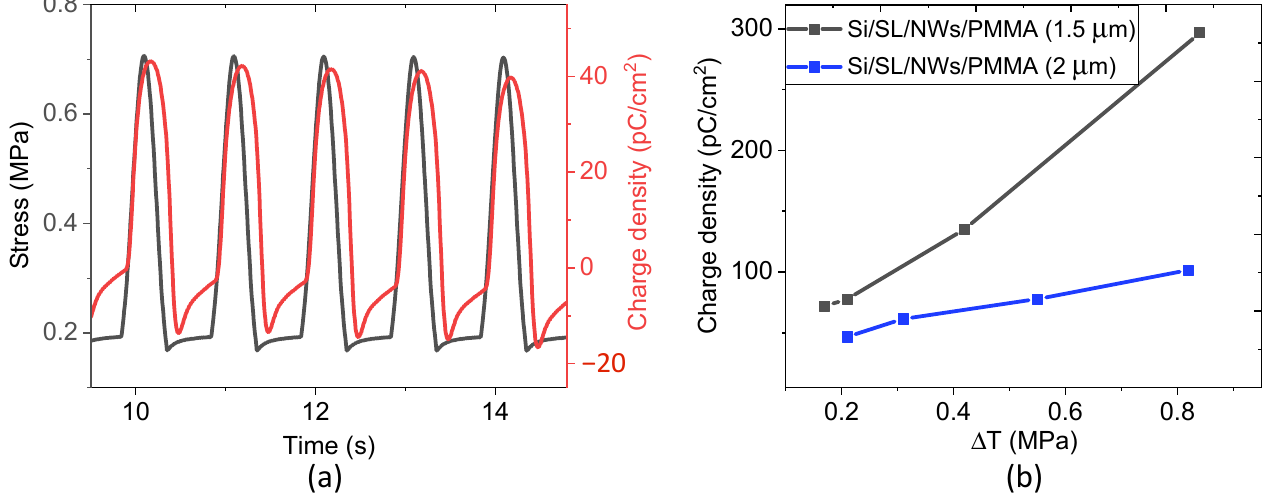
Figure 16. Piezoelectric characterization, performed under a dynamic stress of 1 Hz. ( a ) Time evolution of stress and charge density of the Si/SL/NWs/PMMA (2 µm) composite. ( b ) Piezoelectric charge density versus the dynamic stress of samples with different thicknesses of the top PMMA layer.